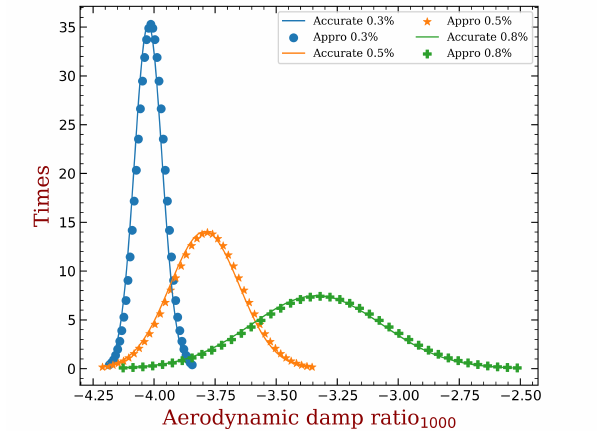
Figure 11. Reconstructing the frequency graph of aeroelastic damping with random mistuning, with